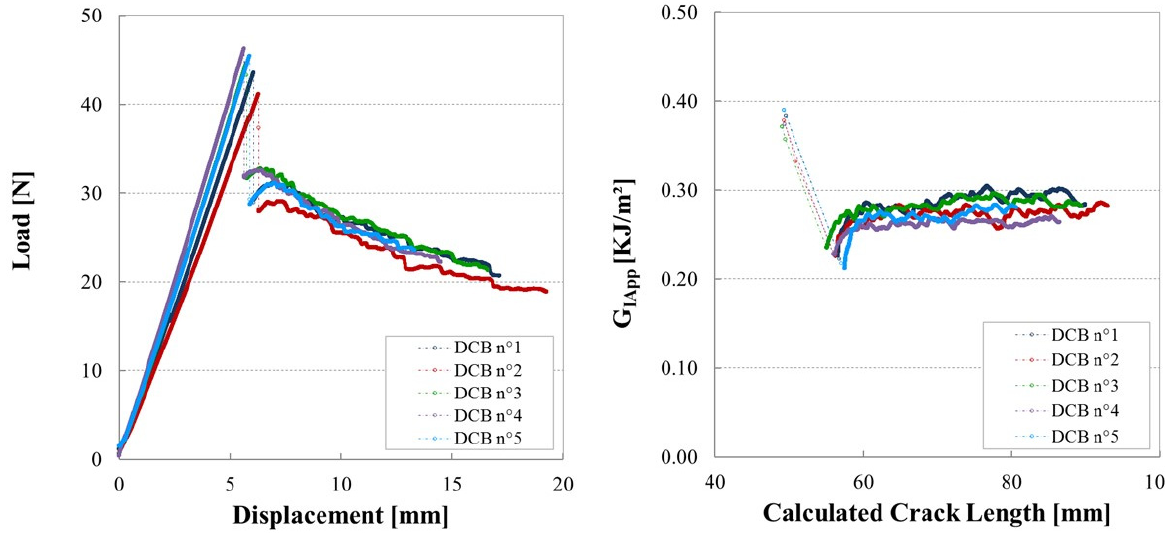
Figure 6. Mode I fracture test results for unidirectional samples without singularities. ( Left ) Force–displacement. ( Right ) Apparent G Ic versus crack length.